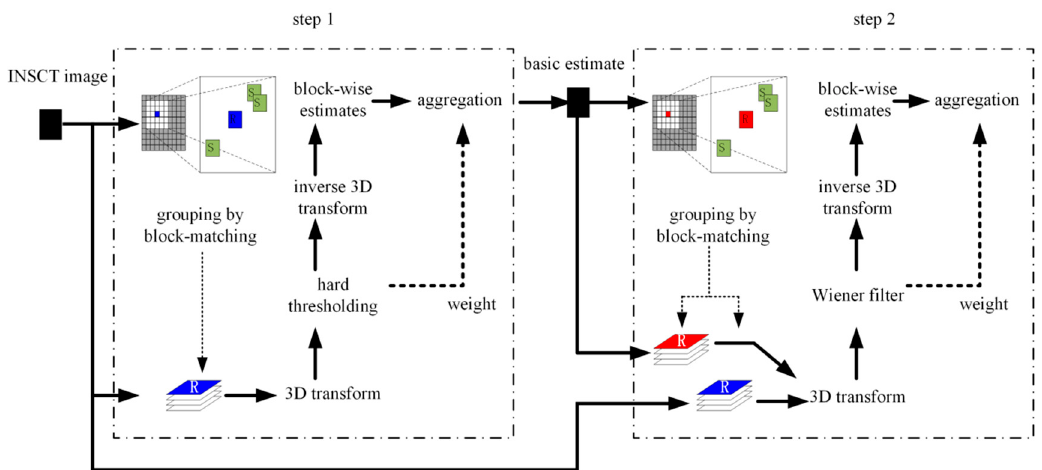
Figure 3. Principle of the blocking-matching 3D filter.